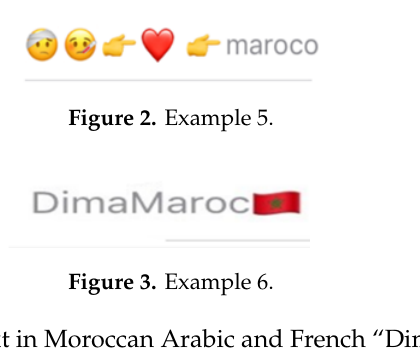
Figure 3. Example 6. Figure 3 (translation): The text in Moroccan Arabic and French “DimaMaroc” translates to “Always Morocco”.